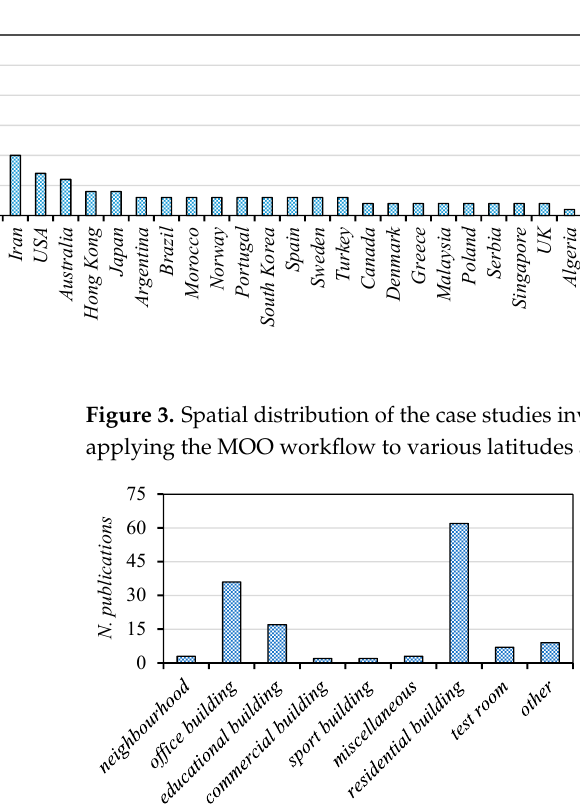
25 studies evaluated life-cycle emissions (LCA category in Figure 5).